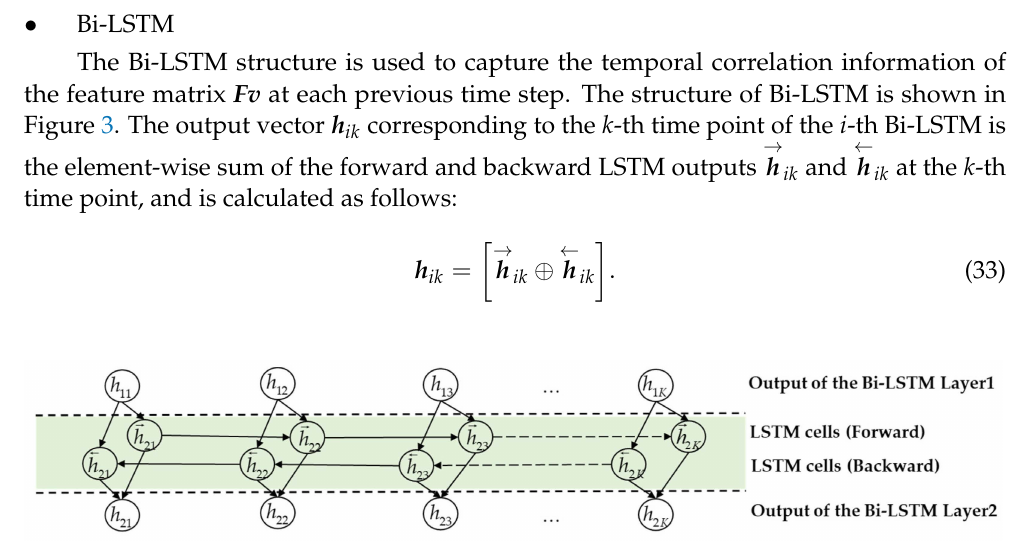
Figure 3. Bi-LSTM structure